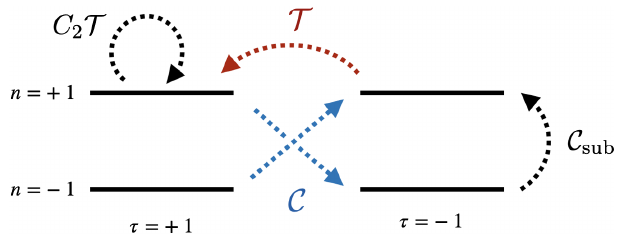
FIG. 9. Schematic diagram illustrating how symmetries in Table III transforms the band basis in TBG. For the absence of a sign problem, enforcing C is most important. The diagram illustrates how we use wave functions at ð τ ; n Þ ¼ ð 1 ; − 1 Þ and both C and T symmetries to generate the wave functions of all other valleys and bands in the projected subspace. However, note that conduction and valence bands are, in fact, degenerate at Dirac points, which is simplified in the diagram. Because of the degeneracy issue, one has to be careful to resolve band indices at degenerate k